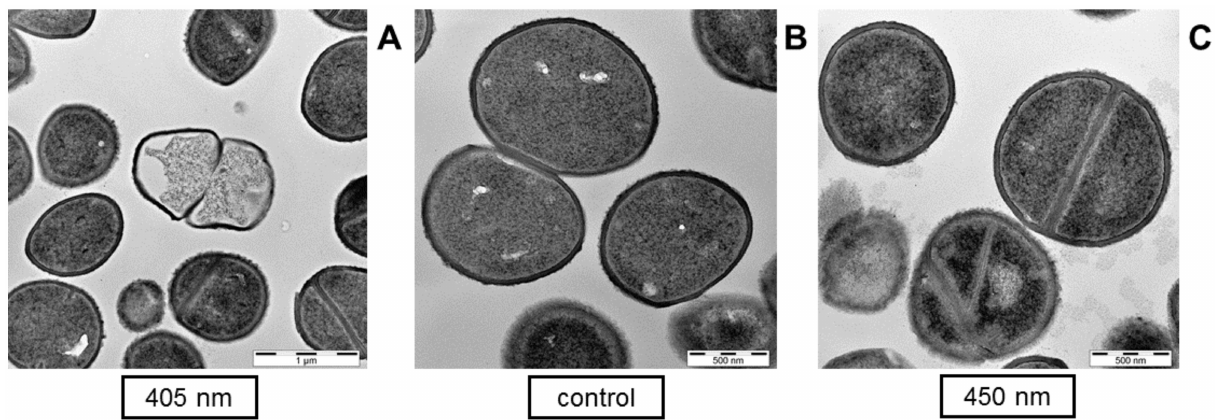
Figure 4. Transmission electron microscopy images of S. carnosus on single cell scale to assess bacterial cell integrity after visible light irradiation. Bacteria are depicted after irradiation with 90 J/cm 2 of 405 nm ( A ), or irradiation with 400 J/cm 2 of 450 nm ( C ) compared to the unirradiated control ( B ). Scale bars show the magnification, representing 1 µ m ( A ) and 500 nm ( B , C